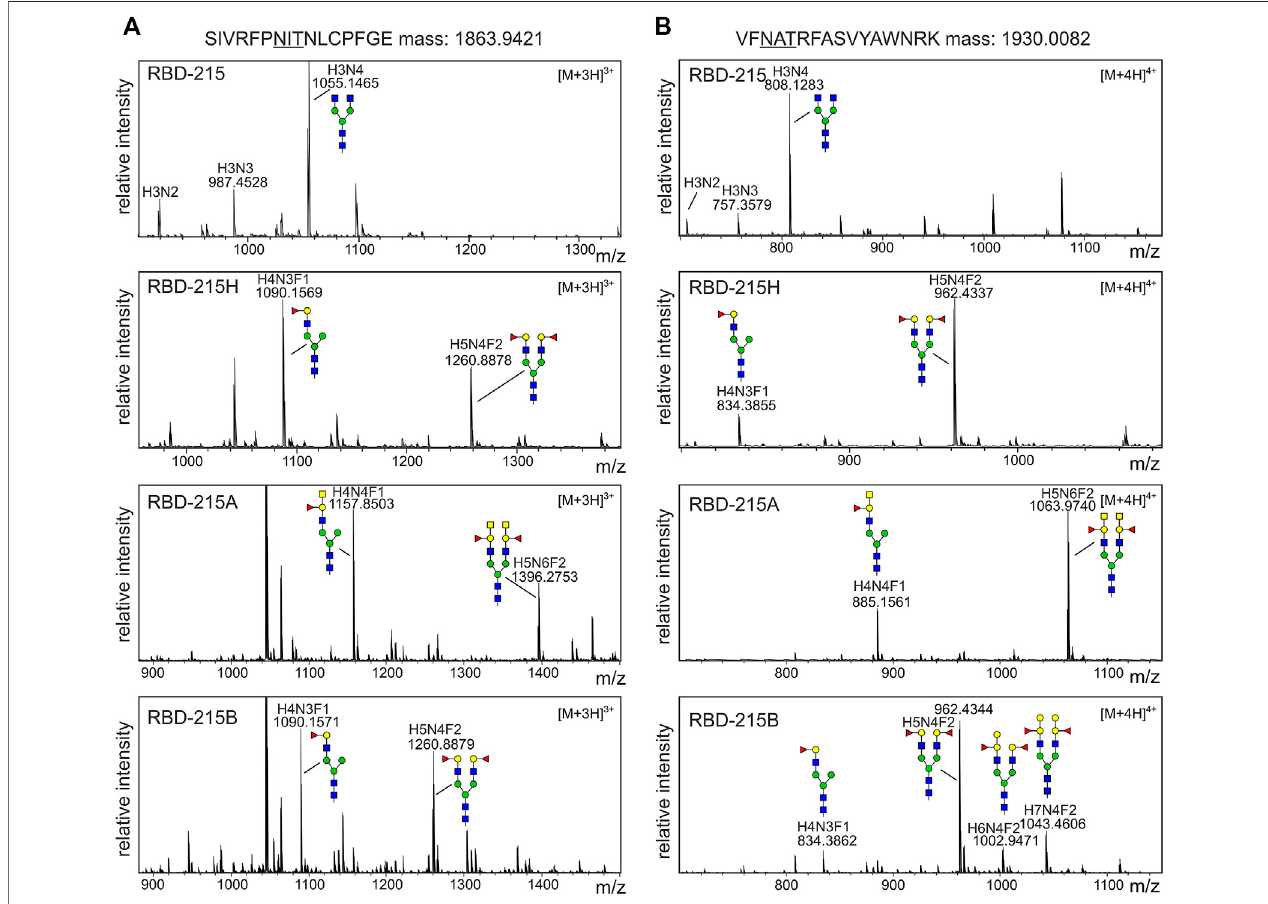
FIGURE 4 | MS spectra of the RBD-215 glycopeptides carrying the N-glycosylation site N331 or N343. IMAC-puri fi ed RBD-215 variants were proteolytically digestedandanalyzedbyMS. (A) GlycopeptidescarryingN331and (B) N343.MajorN-glycanpeaksareillustratedwithacartoonpresentation(see Figure2 fordetails). H: hexose; N: N-acetylhexosamine (HexNAc); F: